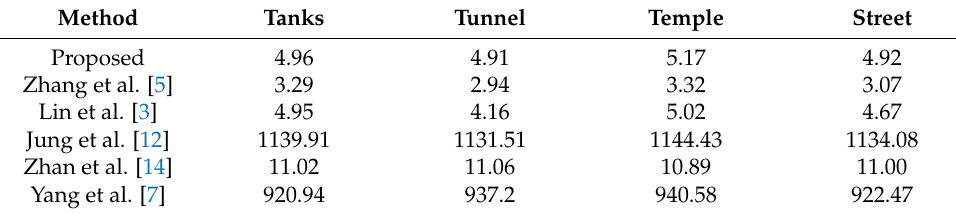
Table 4. Average execution time per frame in seconds for